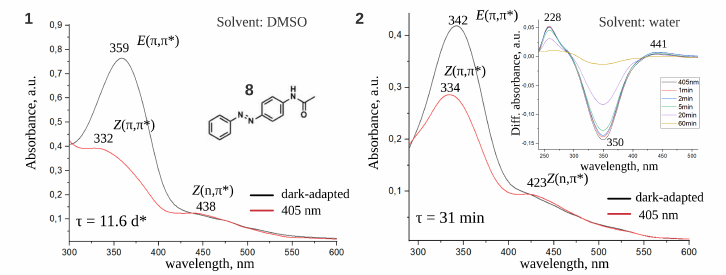
Figure 11. Dark-adapted and light-adapted spectra of compound 8 in DMSO ( 1 ) and water ( 2 ). Transient absorption UV-Vis spectrum in water is shown in the inset. Spectral bands are related to E , Z isomers and ( π , π ∗ ), ( n , π ∗ ) transitions. * Thermal lifetime of E isomer in DMSO from the work